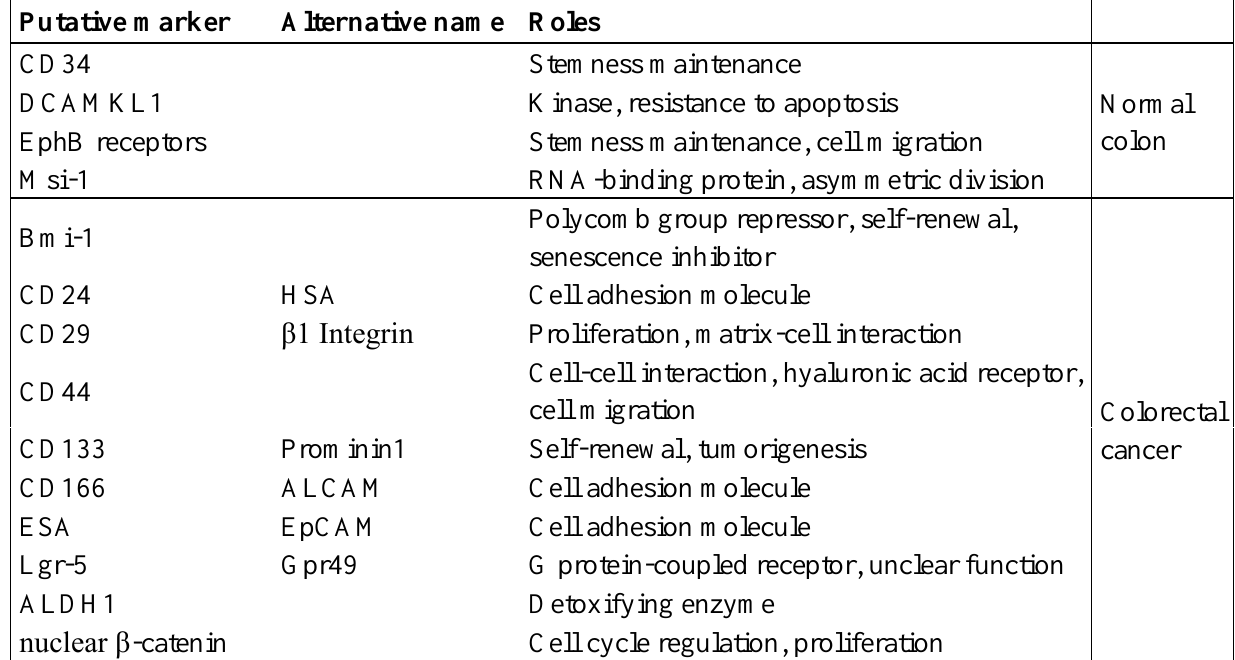
Table 1. Panel representing putative stemness